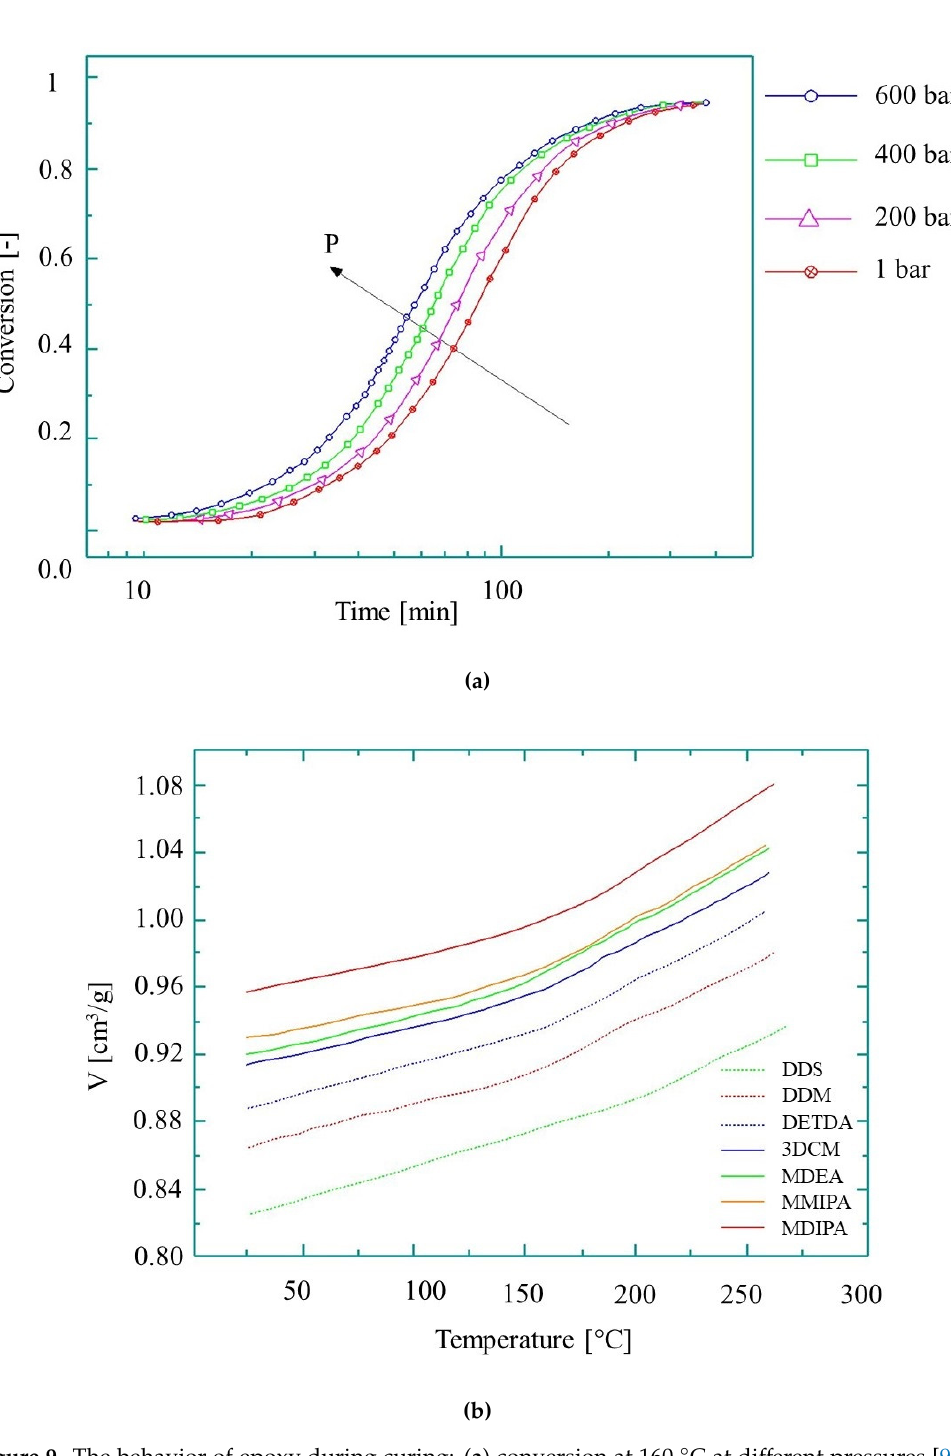
Figure 9. The behavior of epoxy during curing: ( a ) conversion at 160 °C at different pressures [91], reproduced with copyright permission from Elsevier, 2005; ( b ) the pvT diagram (based on reference [92], reproduced with copyright permission from Elsevier, 2004).